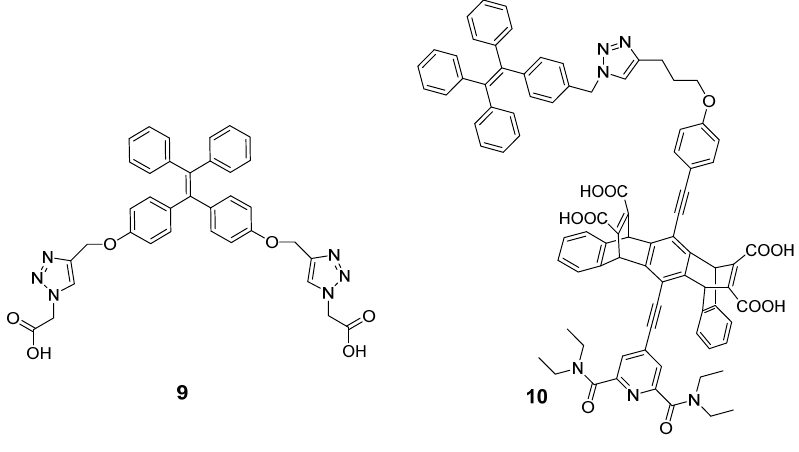
Figure 10. Chemical structures of fluorescent probes 9 and 10